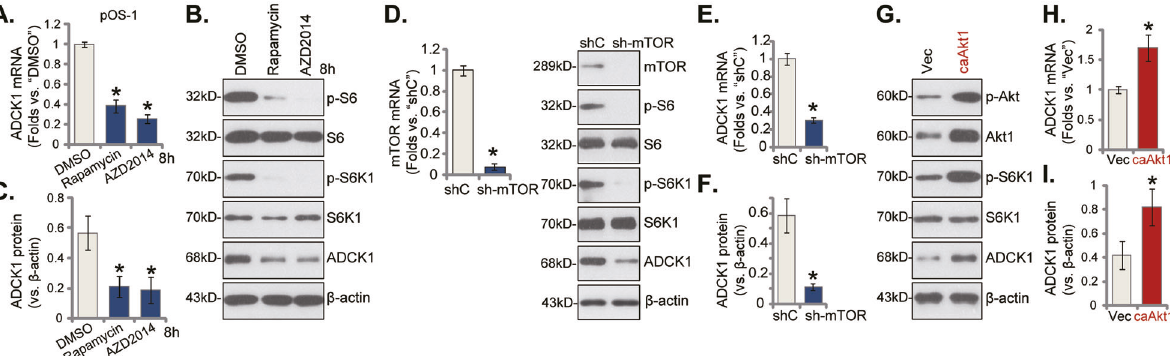
Fig. 7 mTOR activation is important for ADCK1 expression in primary OS cells. The pOS-1 primary cells were treated with 100 nM of rapamycin or AZD2014 for 8 h, expression of ADCK1 mRNA ( A ) and listed proteins ( B , C ) was shown. The pOS-1 primary cells, expressing the mTOR shRNA ( “ sh-mTOR ” ), the scramble control shRNA ( “ shC ” ) ( D – F ), the constitutively active Akt ( “ caAkt1 ” , S473D) or the empty vector ( “ Vec ” ) ( G – I ), were established; Expression of listed proteins and ADCK1 mRNA was shown ( D – I ). Data were presented as mean ± standard deviation (SD, n = 5). “ DMSO ” stands for 1% DMSO. * P < 0.05 vs. “ DMSO ” / “ shC ” / “ Vec ” cells. The experiments were repeated fi ve times with similar results